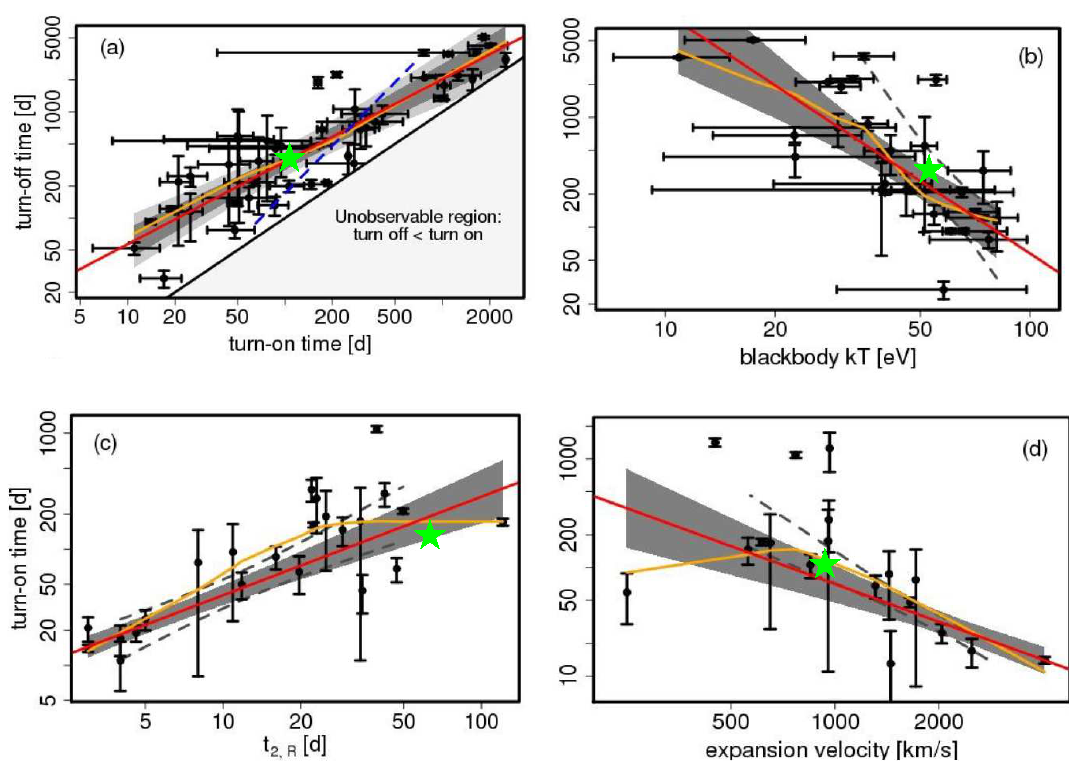
Figure 2: The location of the T Pyx parameters (green stars) with respect to the M 31 nova correlations presented in [20]: (1) the t on -t off correlation, for T Pyx measured from the time of maximum brightness; (2) the kT-t off relation, with kT given by the average value kT=55.7 eV; (3) the relation between t on and t 2 and (4) the correlation between t on and the expansion velocity as measured from the Hα emission